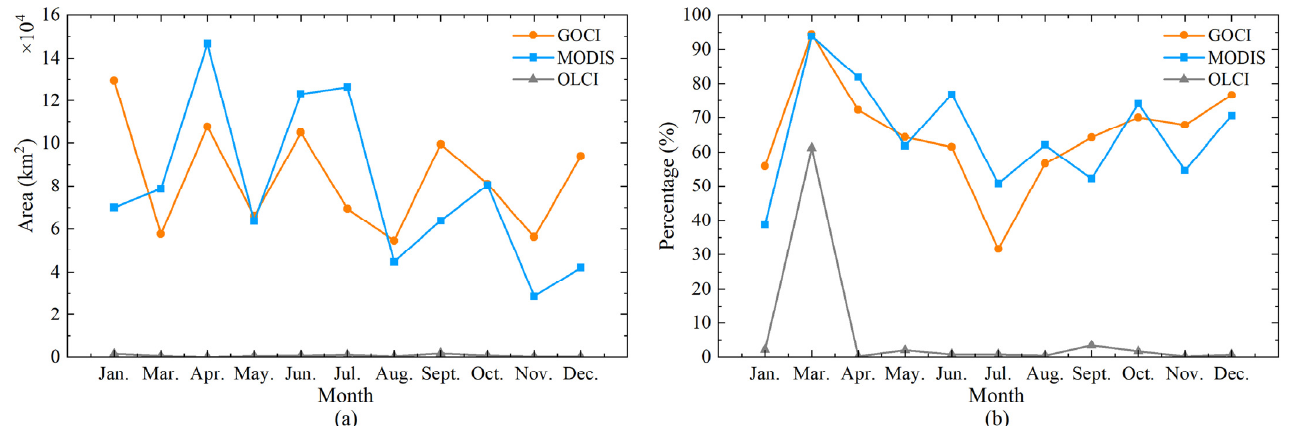
Figure 11. Schematic of the abnormal missing areas and proportions over four seasons (month by month): ( a ) area and ( b ) percentage.